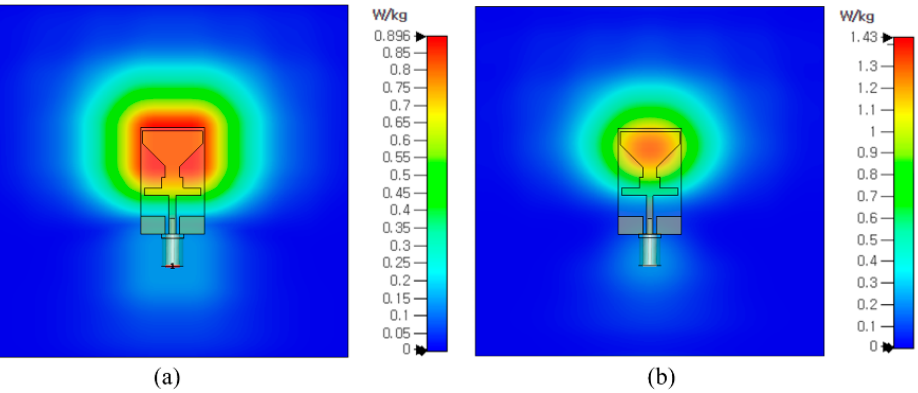
Figure 13. SAR of prosed dual-band antenna at ( a ) 2.4 GHz ( b ) 5.2 GHz.